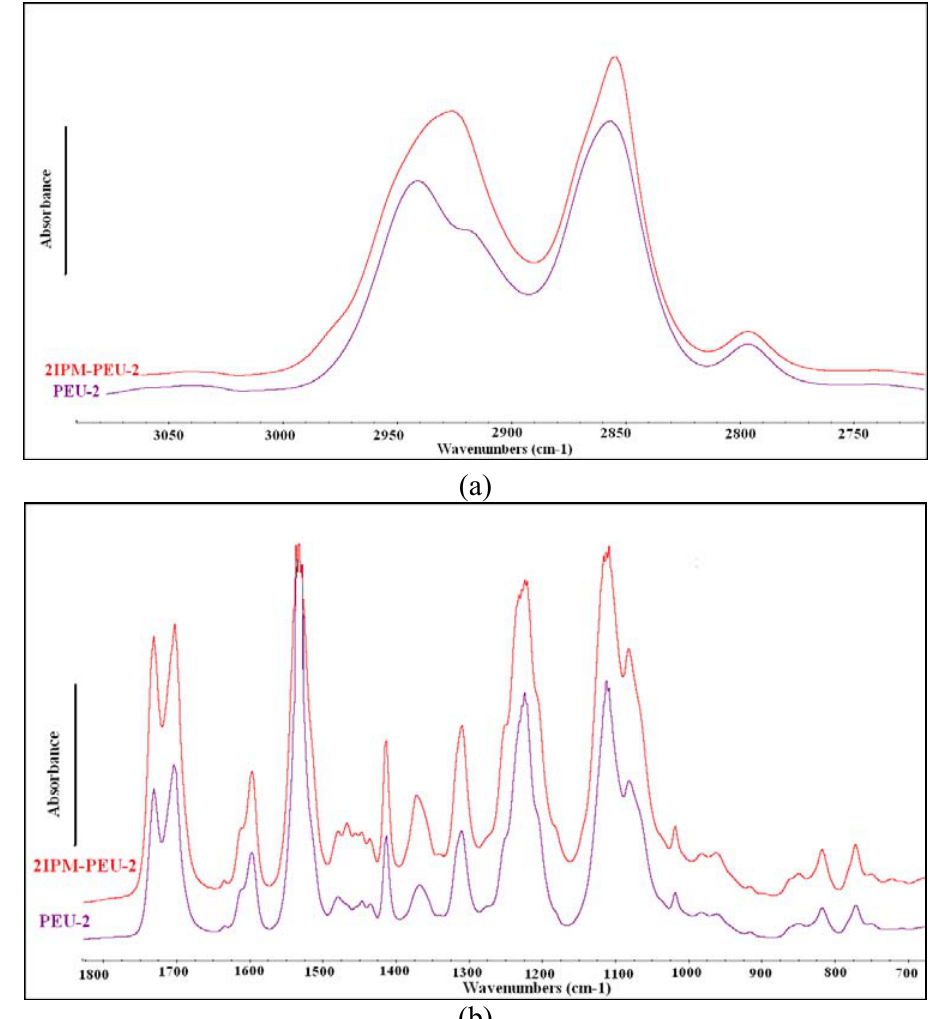
Figure 2. ATR-FTIR spectra of IPM containing polyurethane (2 wt%) compared with unmodified polyurethane, (a) in the range 3,100–2,700 cm − 1 , (b) 1,800–700 cm − 1